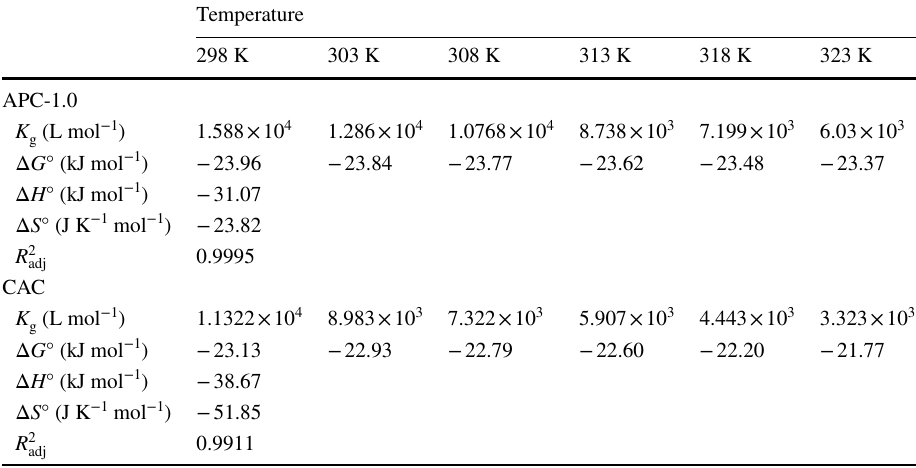
Table 4 Thermodynamic parameters of PR-5B dye adsorption onto APC-1.0 and